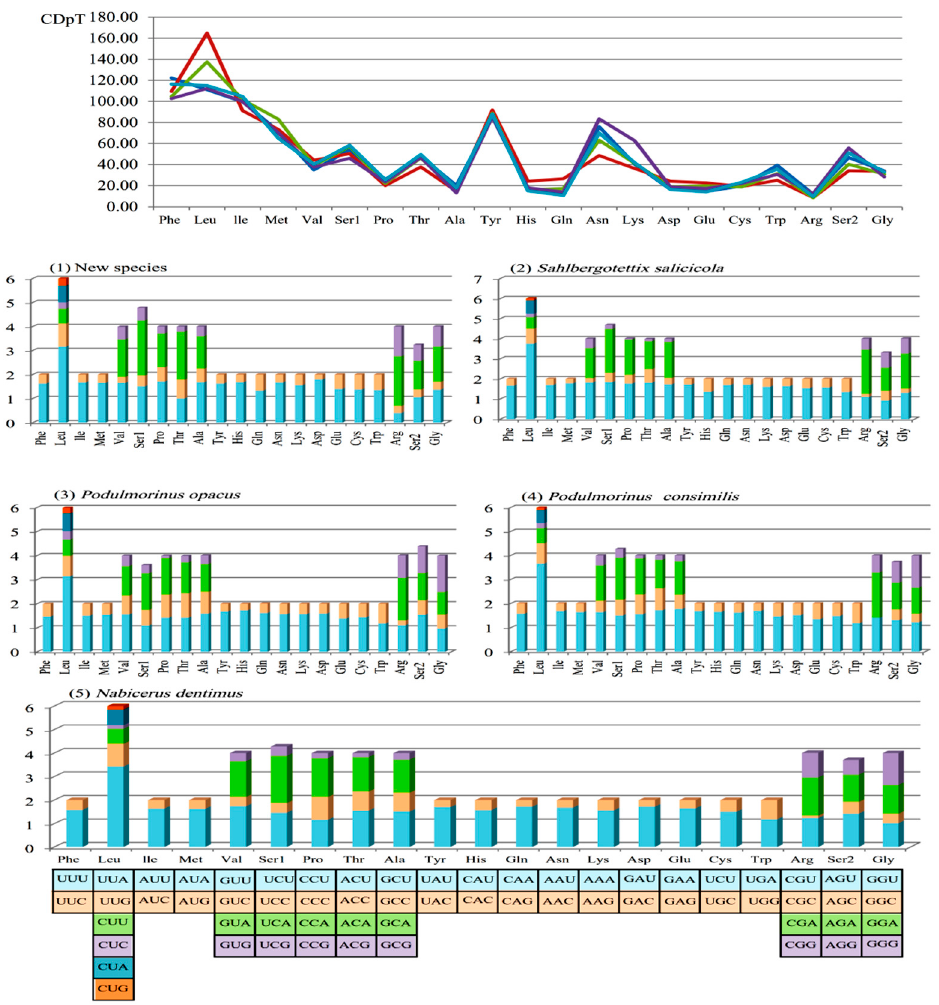
Figure 2. The base composition and the relative synonymous codon usage (RSCU) values (Y axes) of N. dentimus , S. salicicola , P. opacus , P. consimilis, and the new species, respectively. CDpT denotes codons per thousand codons.